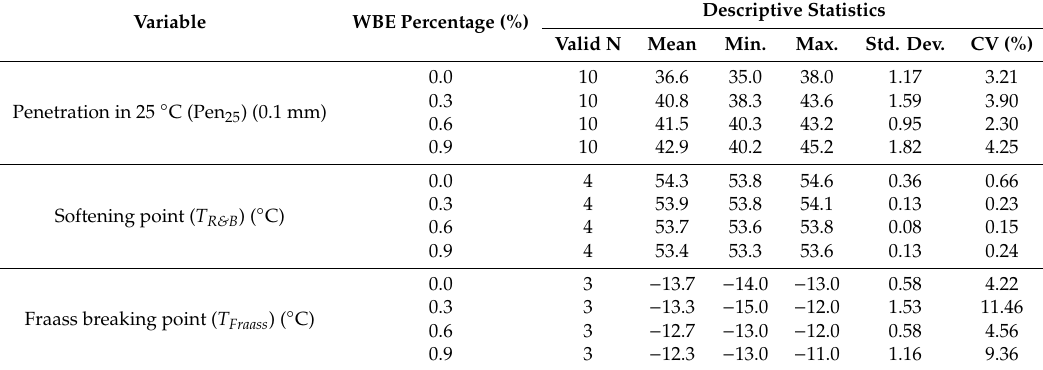
Table 7. Basic properties of 35 / 50 asphalt binders with variable amounts of surfactant. Variable